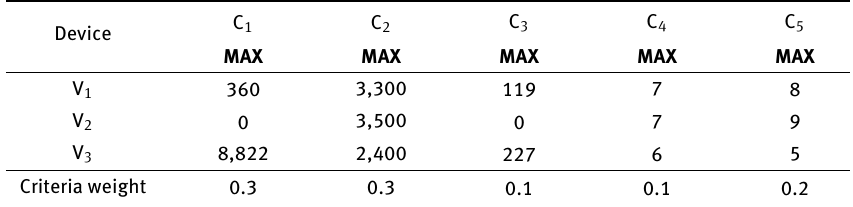
Table 6: Conversion of the minimization criteria into maximization